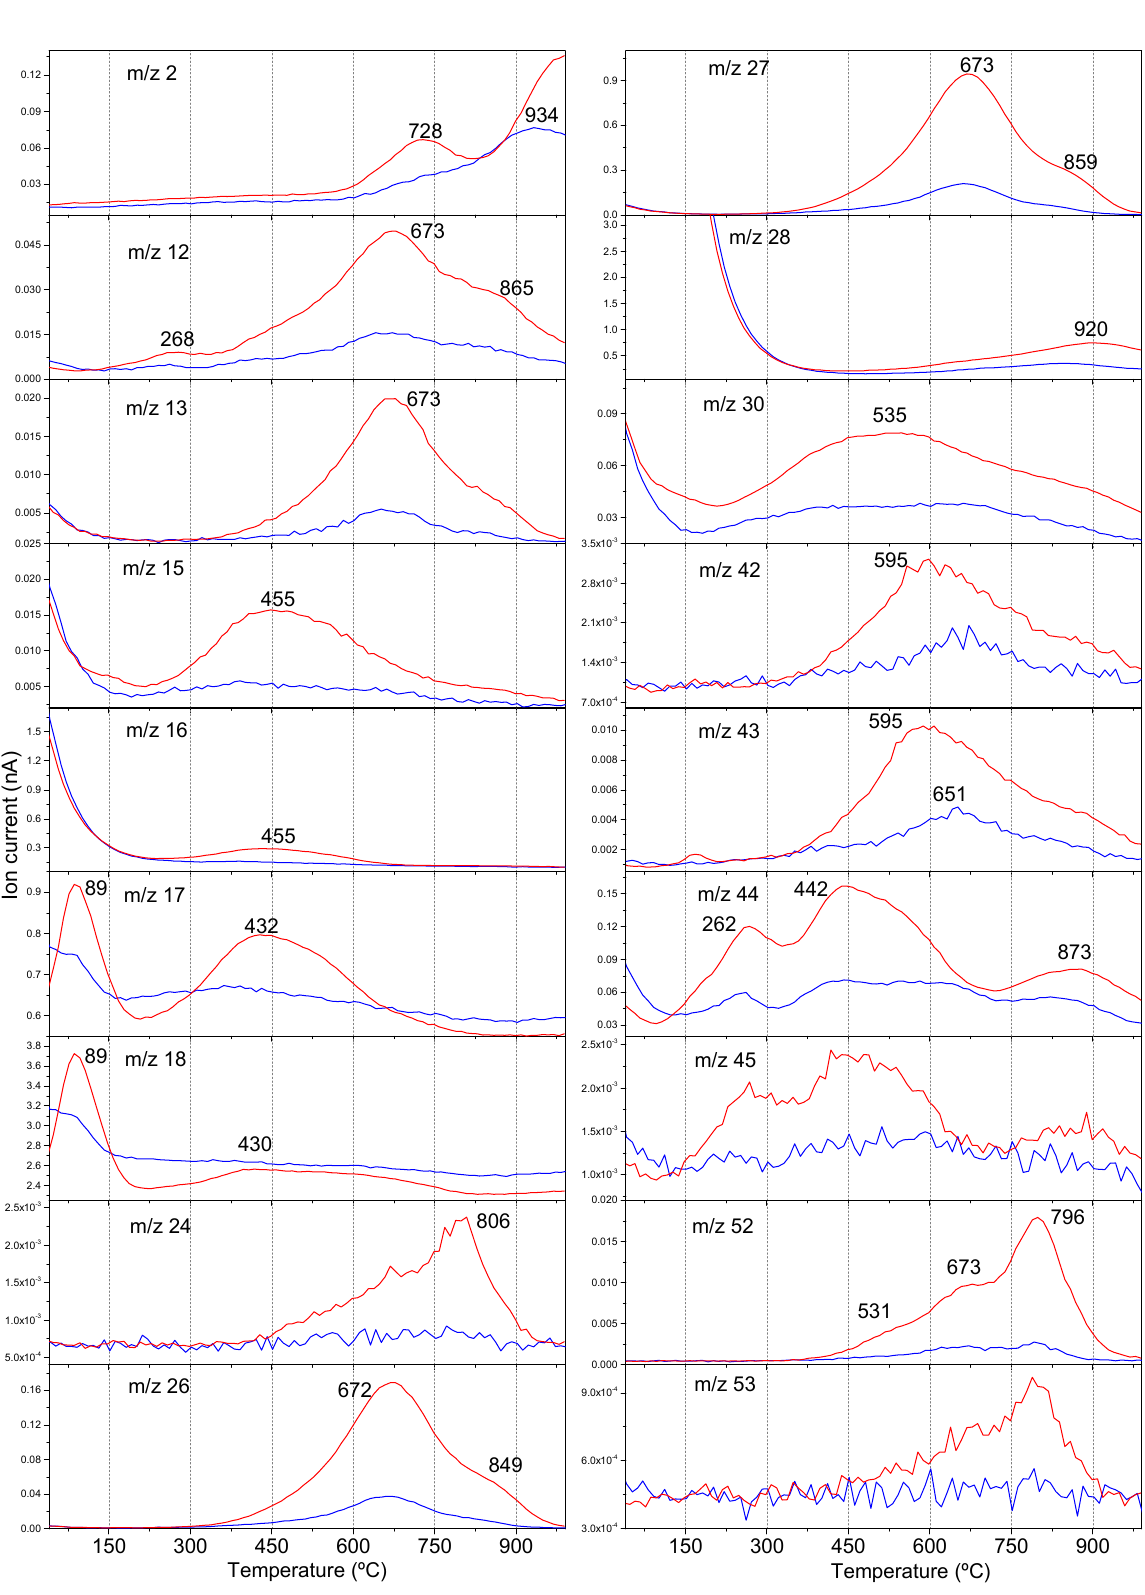
Figure 8. TG − MS curves for NH 4 CN polymers synthesized using MWR and water as solvent. Synthetic conditions of the NH 4 CN polymers, in blue: 170 °C/18 min; in red: 205 °C/2 h. The profiles of all the DTG curves shown in Figure 7d–f are similar to the profiles reported previously for other HCN-derived polymers and they will not be discussed in